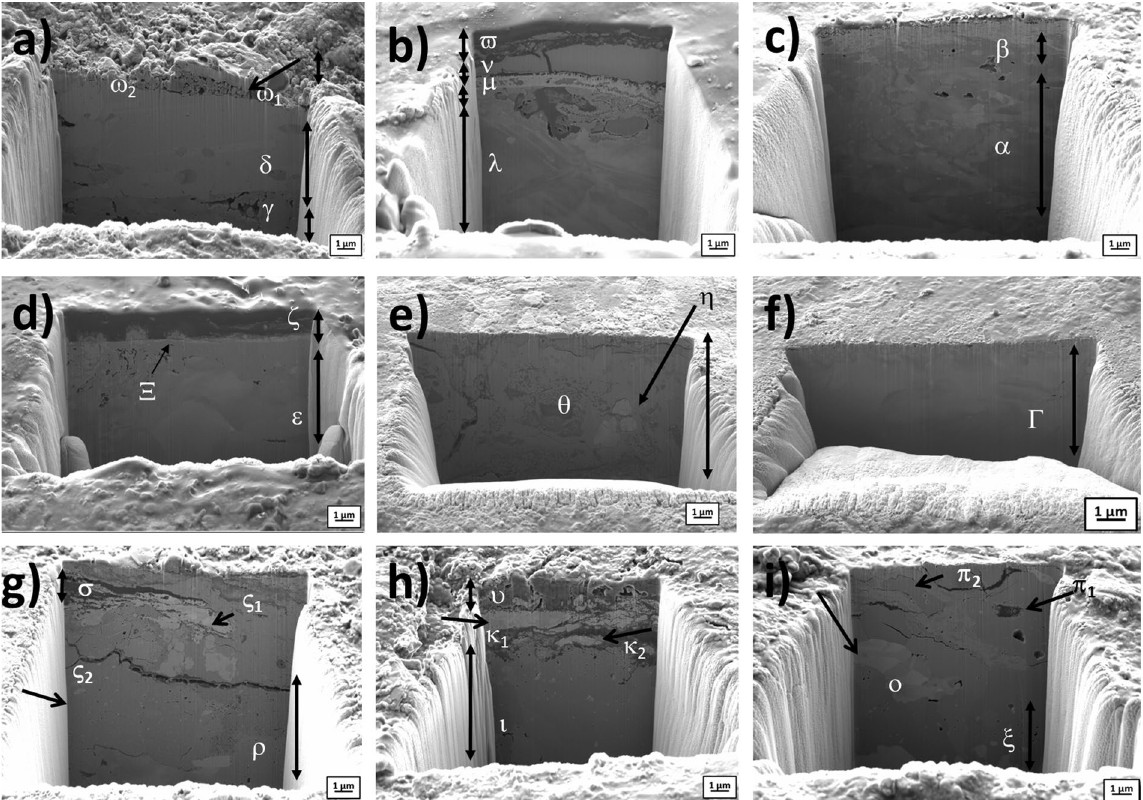
Figure 4. Secondary electron image of the trenches on coins: ( a ) coin F; ( b ) coin C; ( c ) coin A; ( d ) coin Qui21; ( e ) coin Pro46; ( f ) Cla87; ( g ) coin H, (image width 24 μ m); ( h ) coin B, and ( i ) coin D. Points in the different layers and phases where X-ray microanalysis was carried out are labelled with Greek characters. Trench image width 15 μ m.